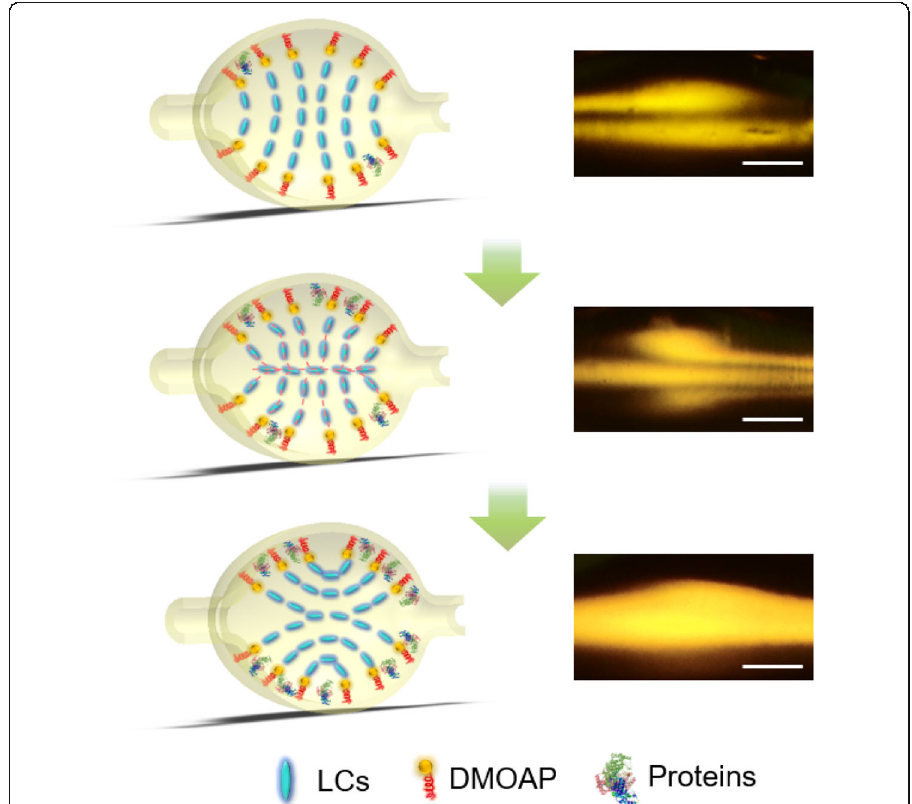
Fig. 1 Under the disturbance of BSA molecules, the ordering of LC in microcavity is changed. With the increase of BSA concentrations, the illustrations of the ordering of LC molecules gradually changes towards the planer molecular orientation from top to bottom (left). The right panel shows the corresponding polarized optical images of LC-amplified optofluidic cavity. Scale bar: 100 μ